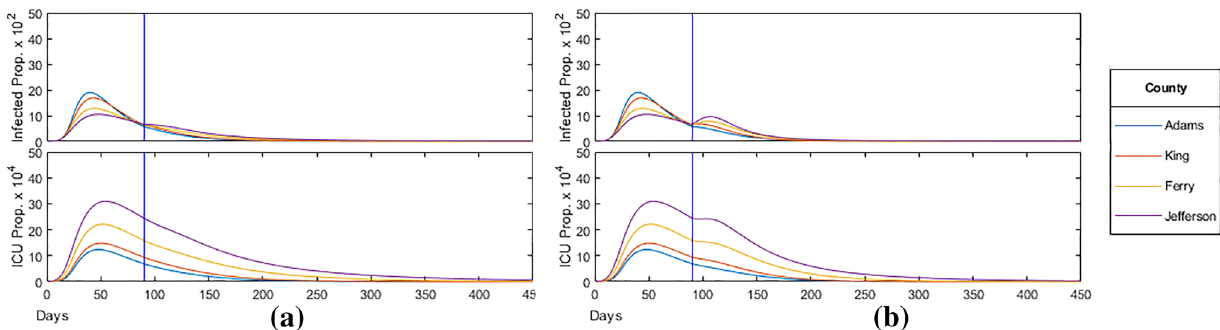
Figure 14. ( a ) School bracket relaxed ( < 30 years) at 90 days; ( b ) work bracket relaxed ( < 60 years) at 90